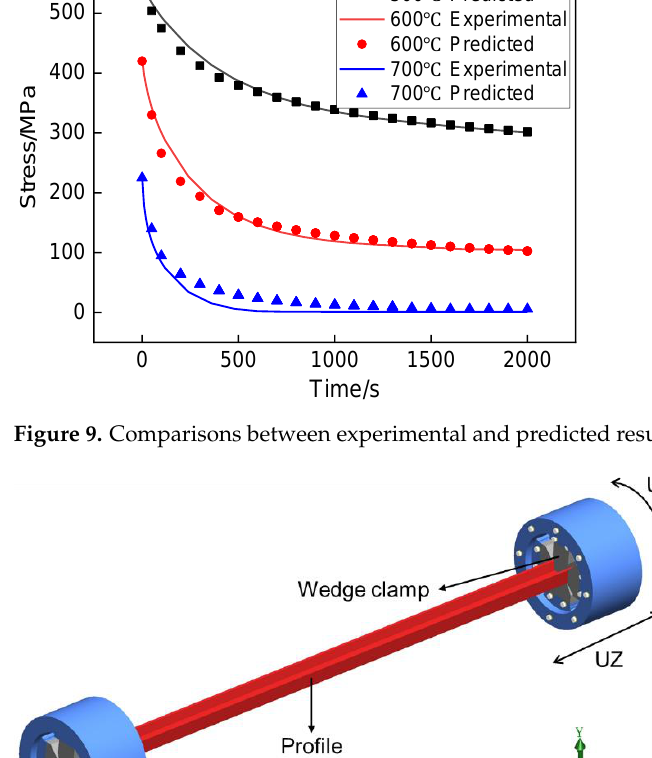
Figure 9. Comparisons between experimental and predicted results.